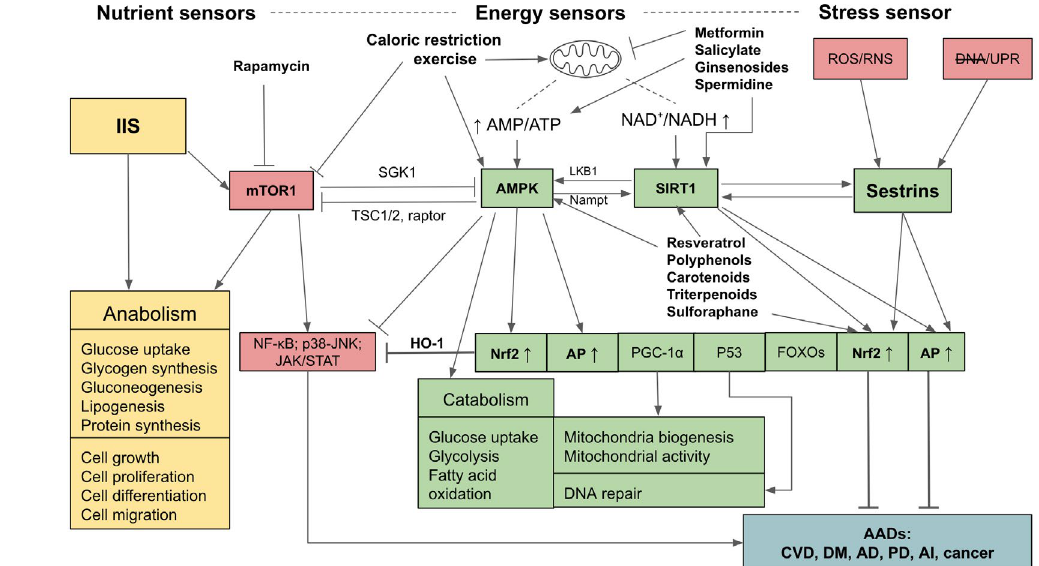
Figure 1. Relationships and interactions between adenosine monophosphate-activated protein kinase, SIRT1, Sestrins, insulin/ insulin-like growth factor signaling, and mammalian targets for rapamycin pathways in sensing nutrient and energy statuses and controls over anabolic and catabolic processes and the outcomes of their activations. mTOR1: mammalian targets for rapamycin 1; AMPK: adenosine monophosphate (AMP)-activated protein kinase; JAK: Janus kinases; STAT: signal transducer and activators of transcription; NF-kb: nuclear factor-kappa B; IIS: insulin/insulin-like growth factor signaling; AI: autoimmune and inflammatory diseases; CVD: cardiovascular diseases; DNA: impaired DNA; LKB1: liver kinase B1; Nampt: nicotinamide phosphoribosyl transferase; HO-1: heme oxygenase-1; SGK1: serum- and glucocorticoid-regulated kinase 1; DM: diabetes mellitus; RNS: reactive nitrogen species; UPR: unfolded protein response; PGC-1 α : peroxisome proliferator-activated receptor gamma coactivator-1 α; TSC1/2: tuberous sclerosis protein 1/2; P53: tumor protein 53 or transformation-related protein